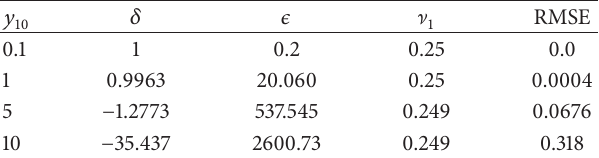
Table 2: Comparison of the numerical integration solutions of the equivalent and the original equations of motion for the parameter values 𝛼 = 1 , 𝛽 = 20 , 𝛾 = 0.1 , ] = 0.25 , 𝜎 = 0.773 , and 𝜐 = 100, 000 .